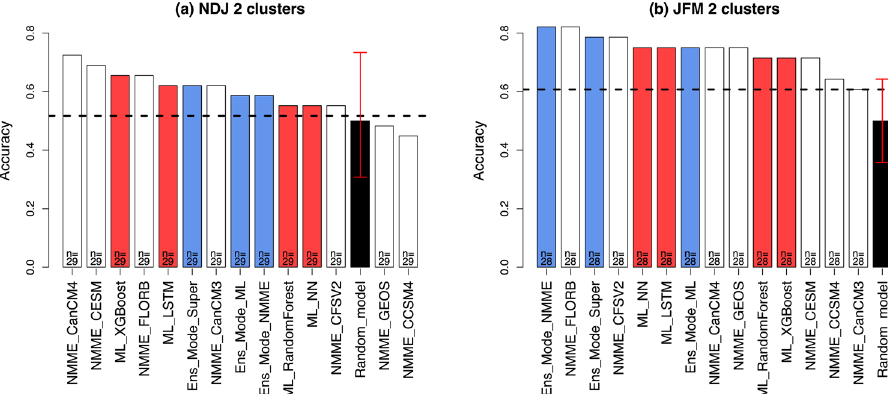
Fig. 3 Improved accuracy from combining clusters. As in Fig. 2 but here accuracy is computed after clusters have been grouped together with clusters 1,2 forming a new cluster (broadly representing a wet southwest), and clusters 3,4 forming a new cluster (broadly representing a dry southwest) for NDJ (panel a ) and JFM (panel b ) seasons. Refer to Fig. 1 for cluster patterns. Here accuracy is computed across overlapping years between models, refer to Supplementary Material Fig. S12 for accuracy across all years.